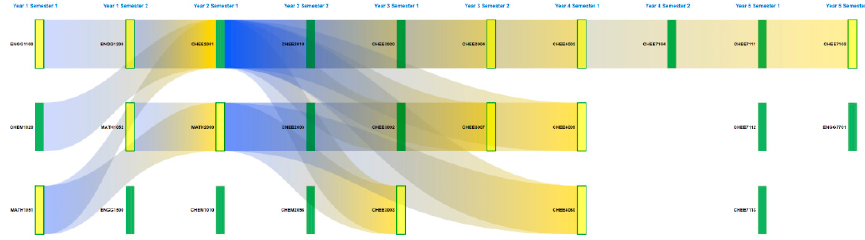
Figure 14. Tracking linkages between courses that have specified required prior learning.